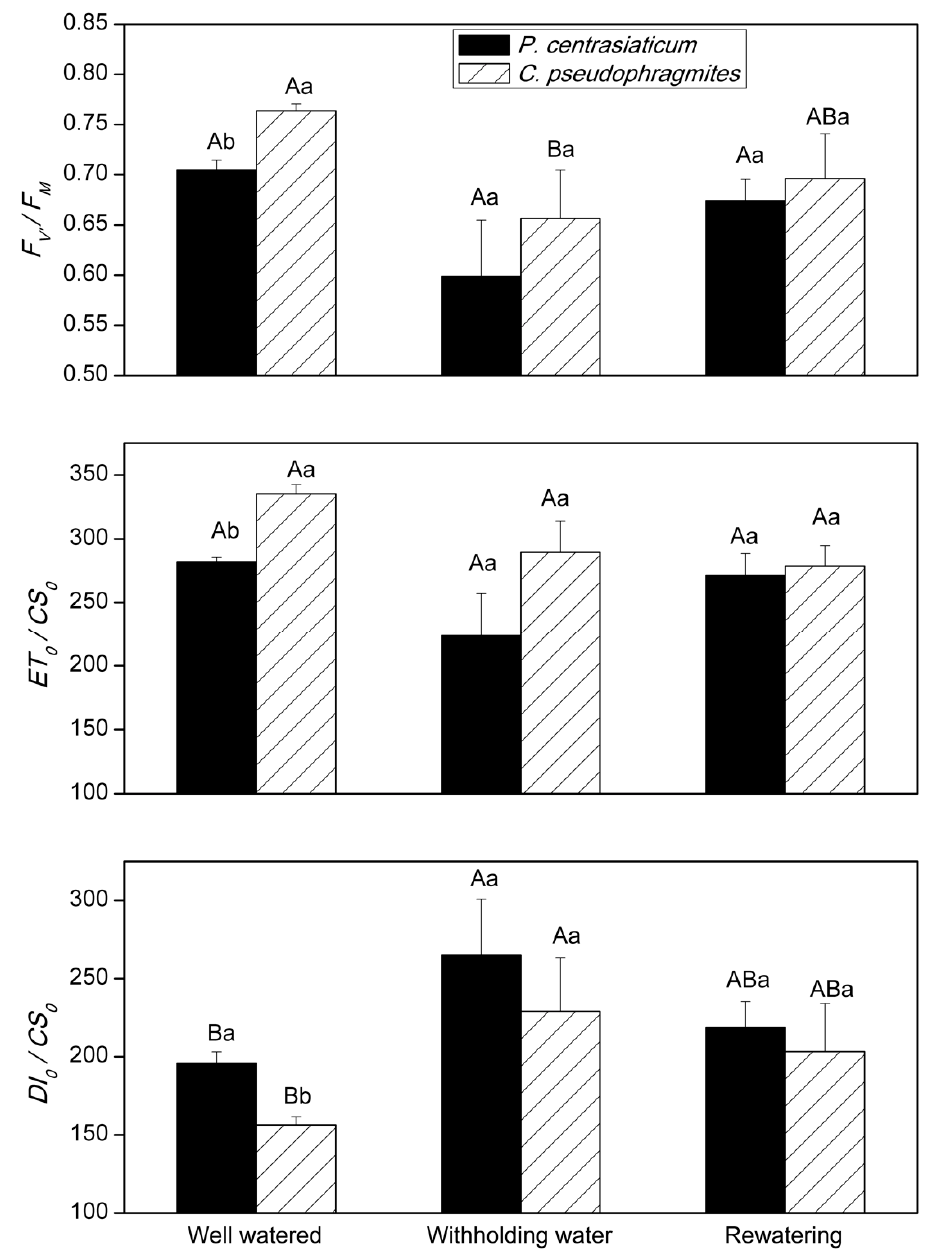
Figure 3. Changes in leaf F V / F M (maximum quantum yield of PS II), ET 0 / CS 0 (electron transport flux) and DI 0 / CS 0 (dissipated energy flux) during soil drought and rewatering for P. centrasiaticum (C 4 ) and C. pseudophragmites (C 3 ), respectively. There were ten, six and four days of measurement for well-watered, withholding water and rewatering, respectively. Differences among well-watered, withholding water and rewatering were marked with capital letters. Differences between two species were marked with lowercase letters. Values are means ± SE.